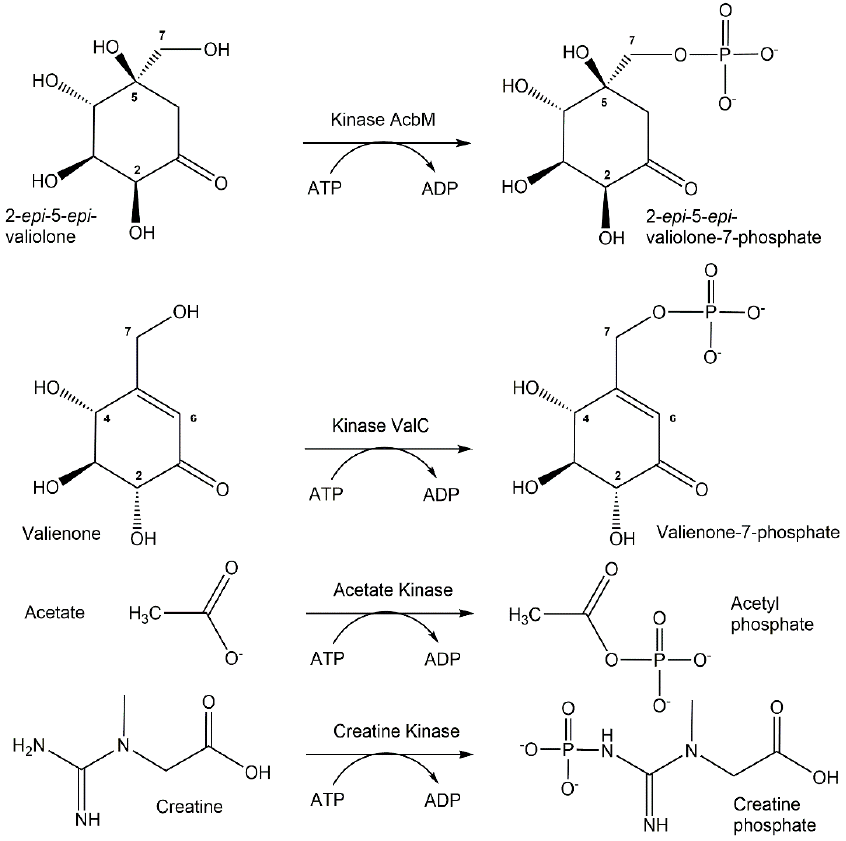
Figure 3. Selected phosphotransferases for catalyzing phosphorylation reactions.